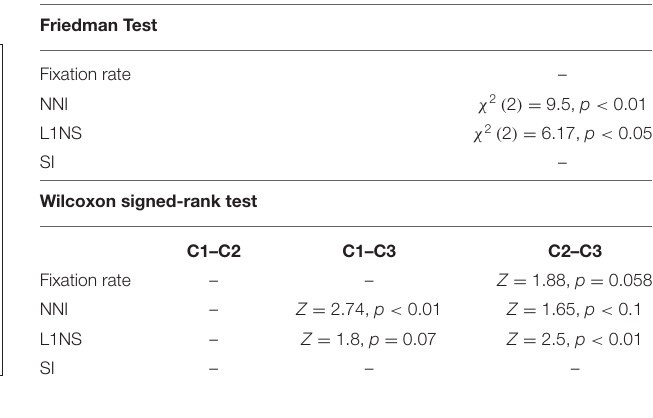
FIGURE 8 | L1NS for left and right pupil diameters.